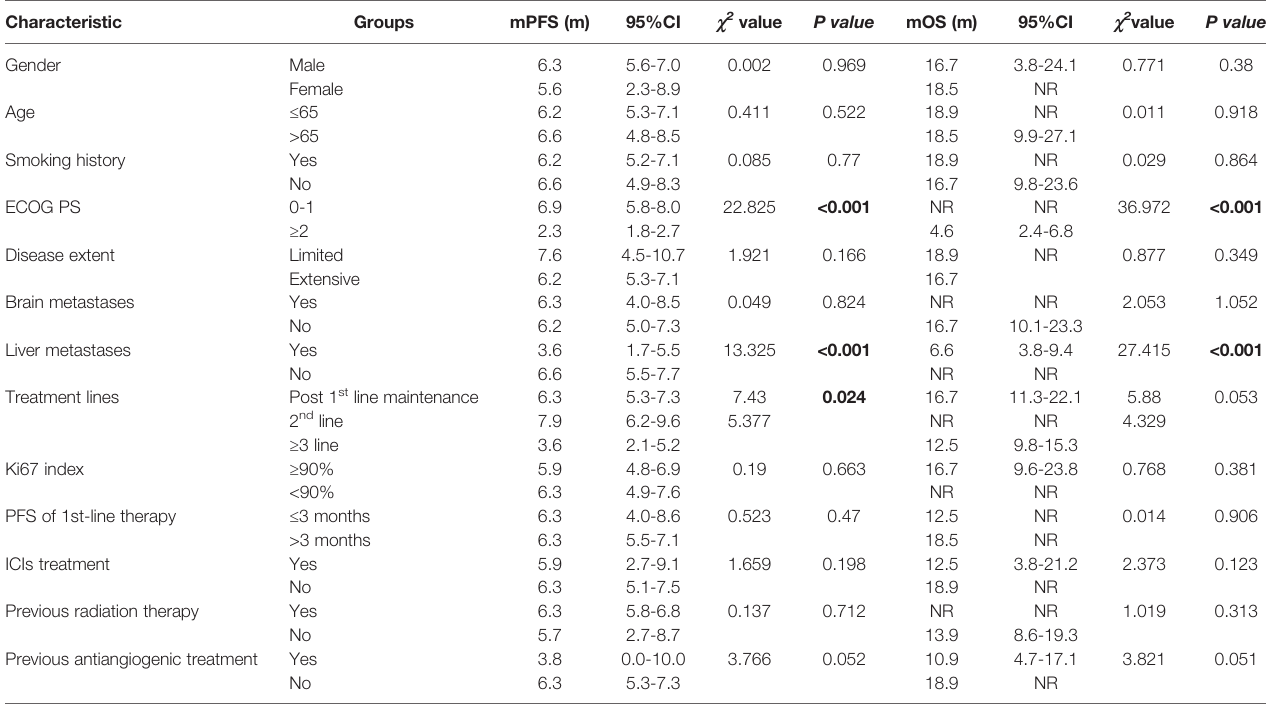
TABLE 3 | Univariate survival analysis.